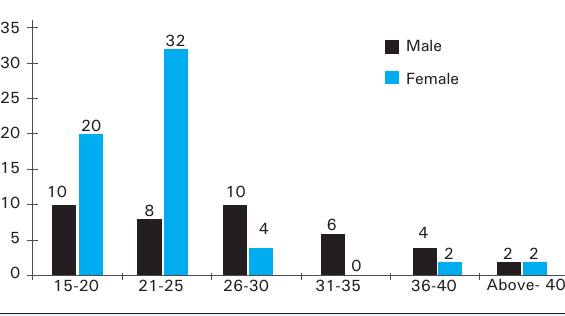
Figure 1. Age and sex distribution of patients Figure 2. signs and symptoms at